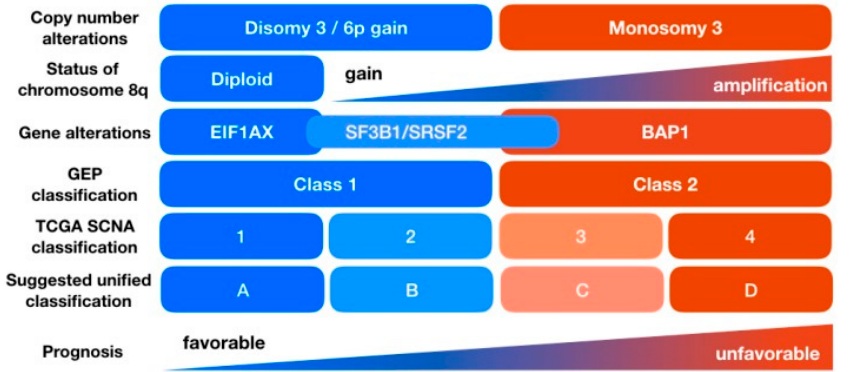
Figure 1. Schema of TCGA UM Subtypes. Reprinted from “Molecular Characteristics of Uveal Melanoma: Insights from the Cancer Genome Atlas (TCGA) Project,” by Matheiu F. Bakhoum and Bita Esmaeli. 2019, Copyright 2019 by authors [28] .